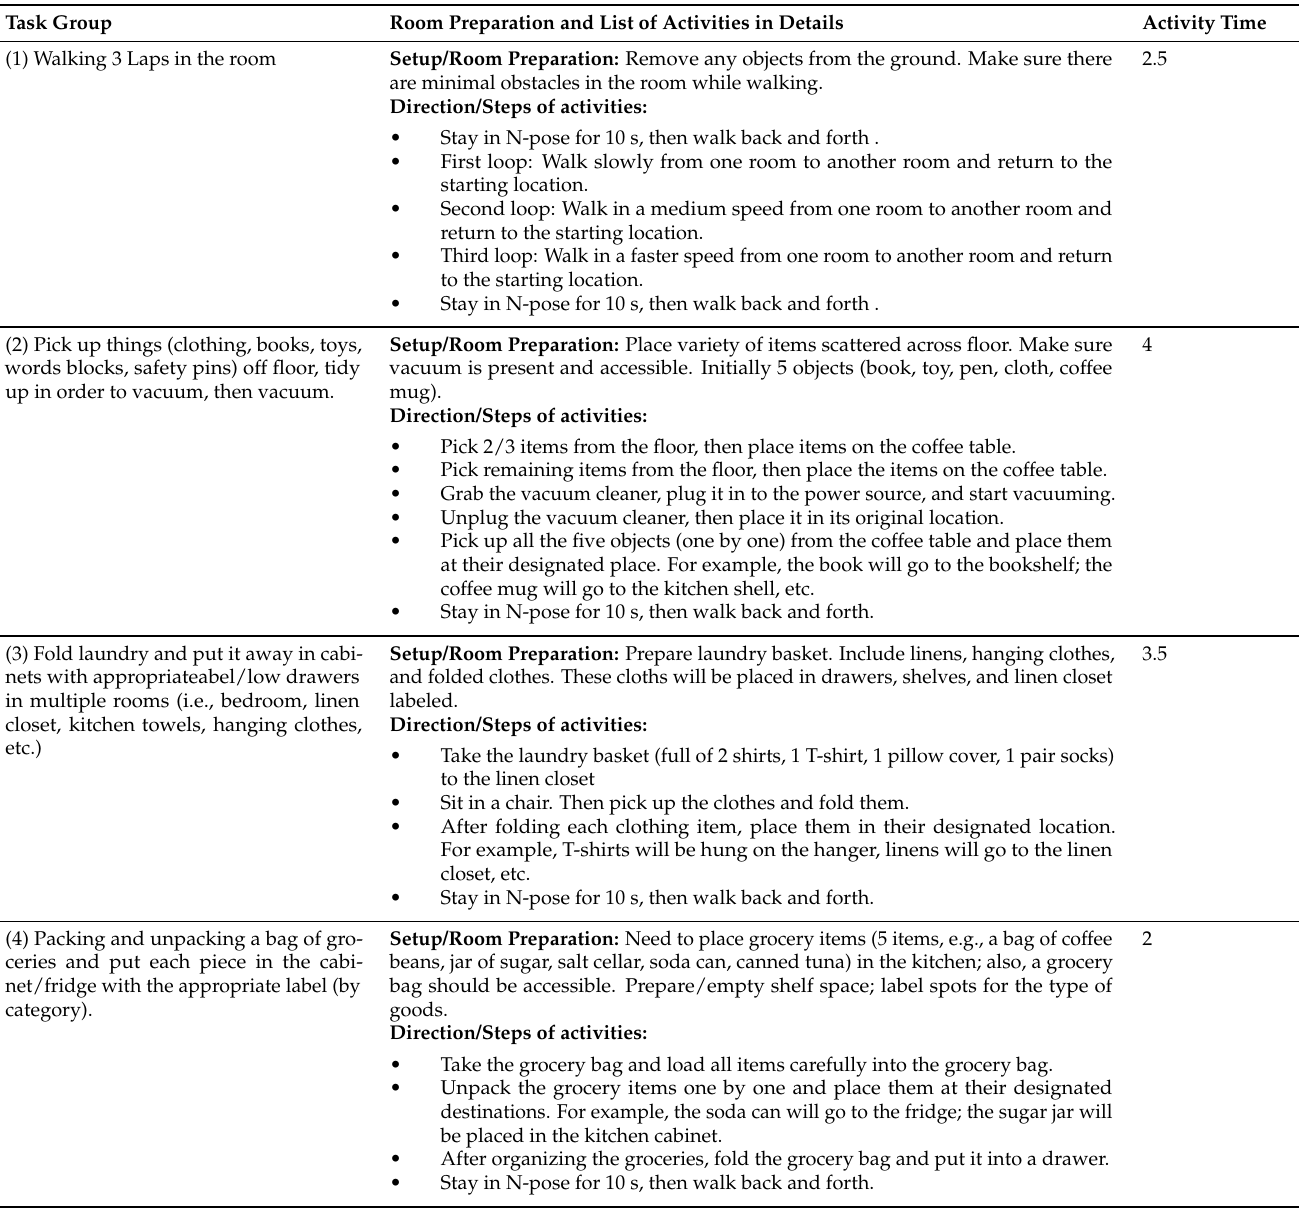
Table A1. List of activities performed by the new participants. The Activity Time is the approximate number of minutes to complete the